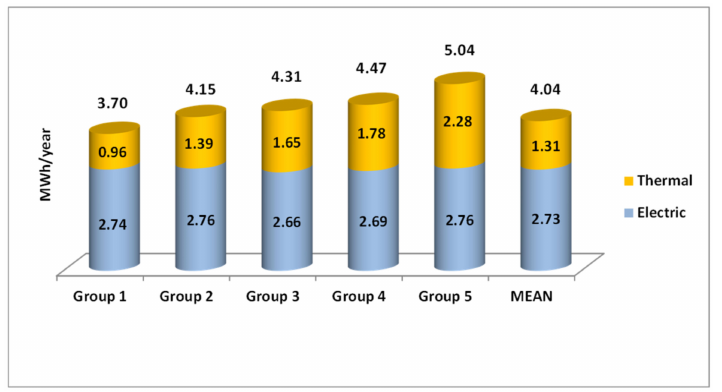
Figure 11. Thermal, electric, and total mean energy consumptions per inhabitant by group of cities without the influence of climate.